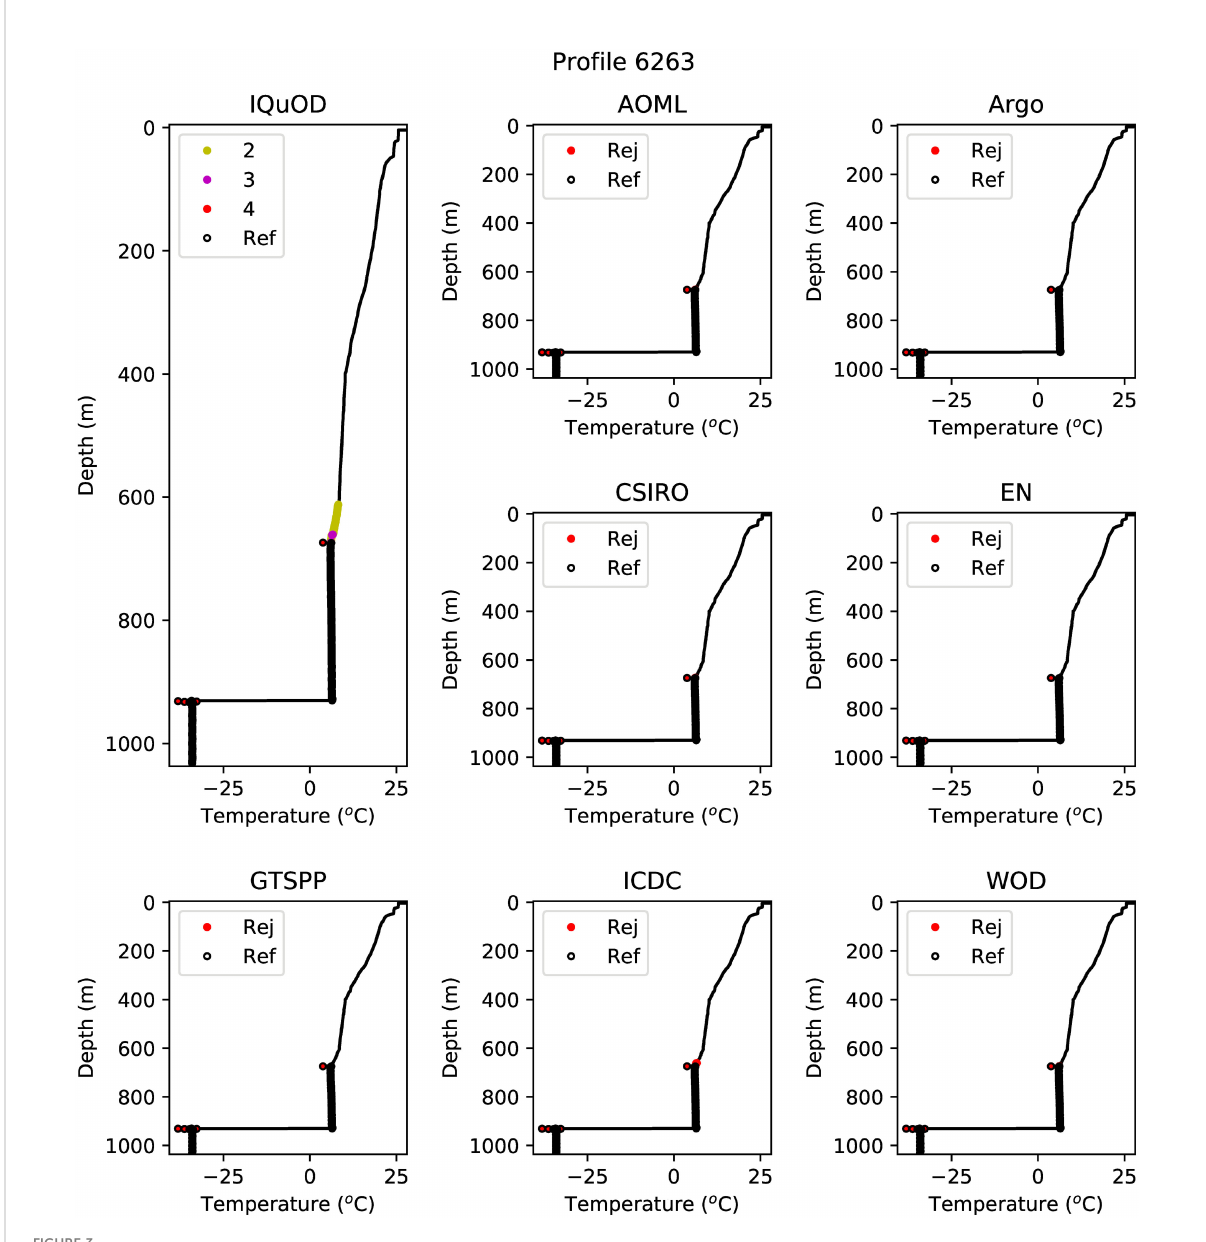
FIGURE 3 Example XBT pro fi le from the QuOTA dataset. This was recorded on 23 March 1999 at 25.5167°S, 111.9167°E. For each set of QC results, the reference ( ‘ Ref ’ ) fl ags are shown by open black circles. Measurements rejected ( ‘ Rej ’ ) by the QC set are shown as fi lled red circles, except for the IQuOD QC sets derived in this study where the rejected measurements are assigned the number 2 (shown as a yellow fi lled circle), 3 (magenta) or 4 (red), with a higher number denoting increased con fi dence in the